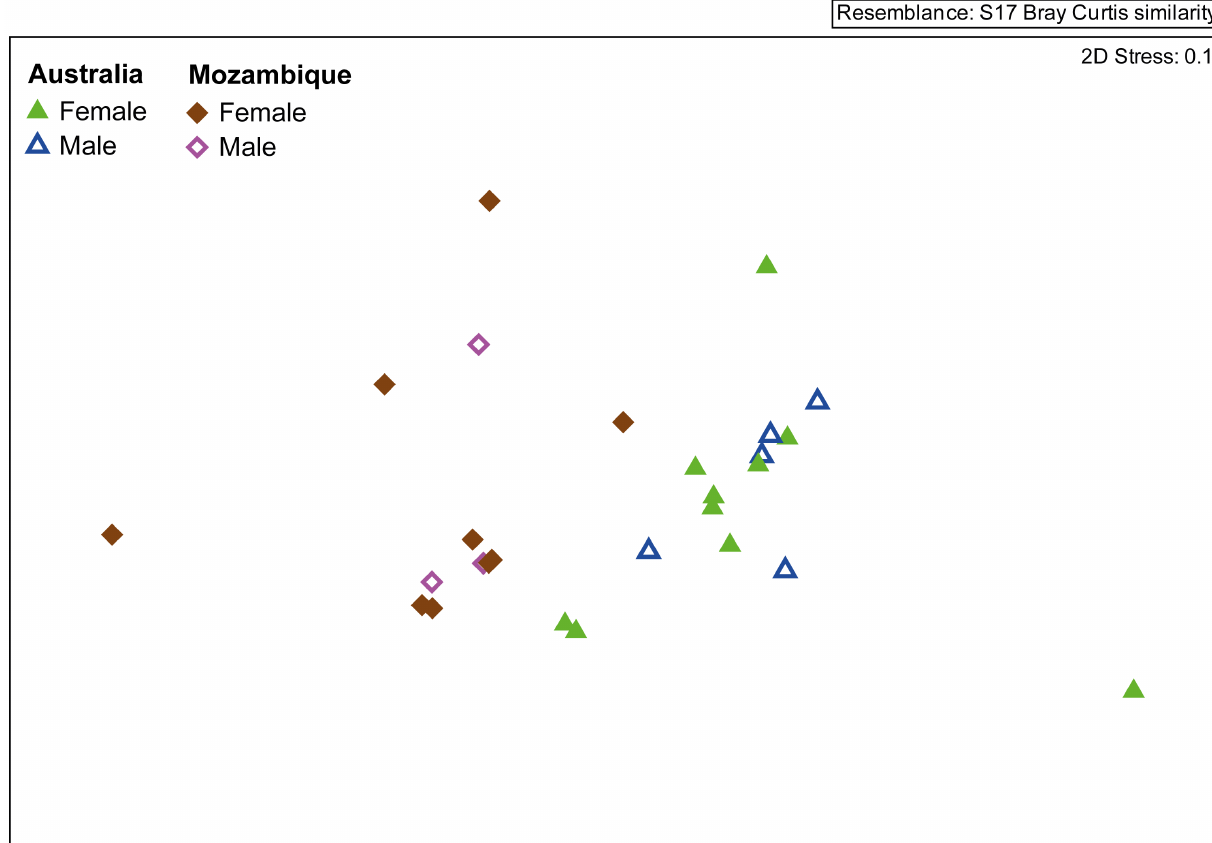
Zooplankton mix (Australia)